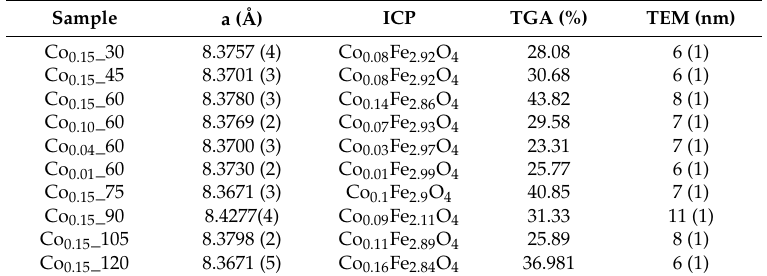
Table 1. Cell parameter, a (Å), obtained from the fitting of XRD patterns. Cobalt content in ferrites, determined by chemical analysis, percentage of surface coating calculated from thermal analysis, and particle sizes obtained from TEM analysis.